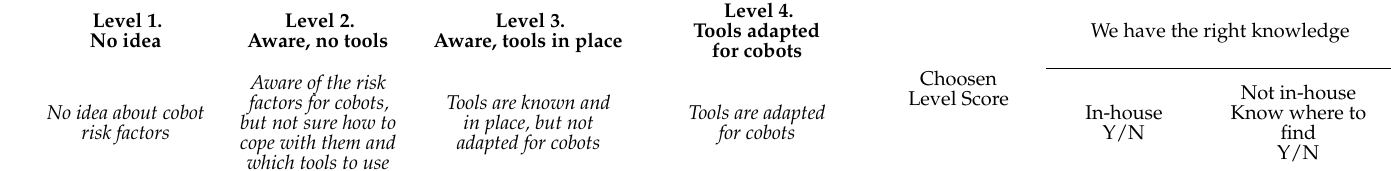
Table 1. Illustration of the CSRAT for one grid